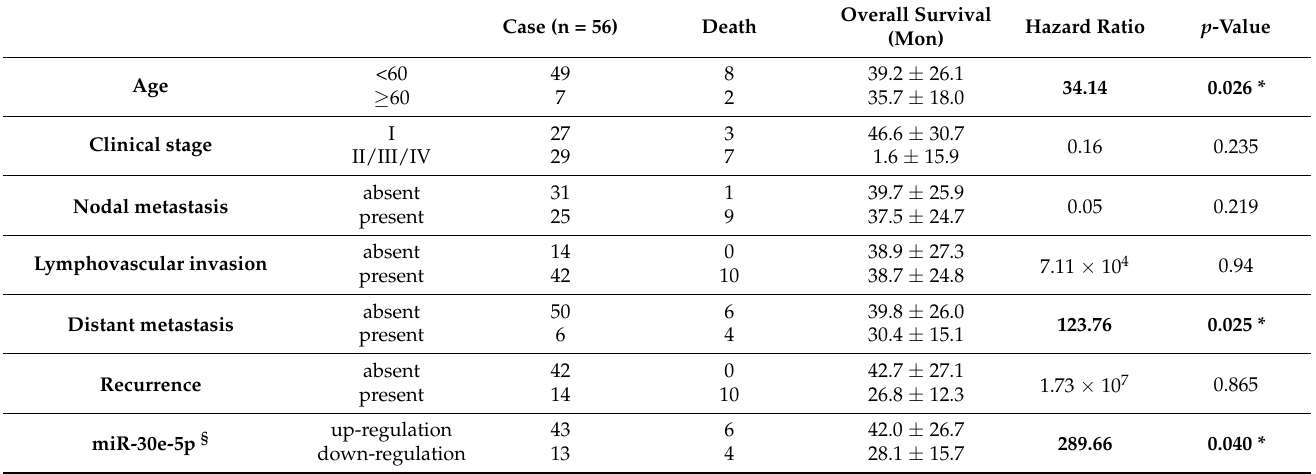
Table 5. Multivariate Cox analysis of miR-30e-5p in cervical squamous cell